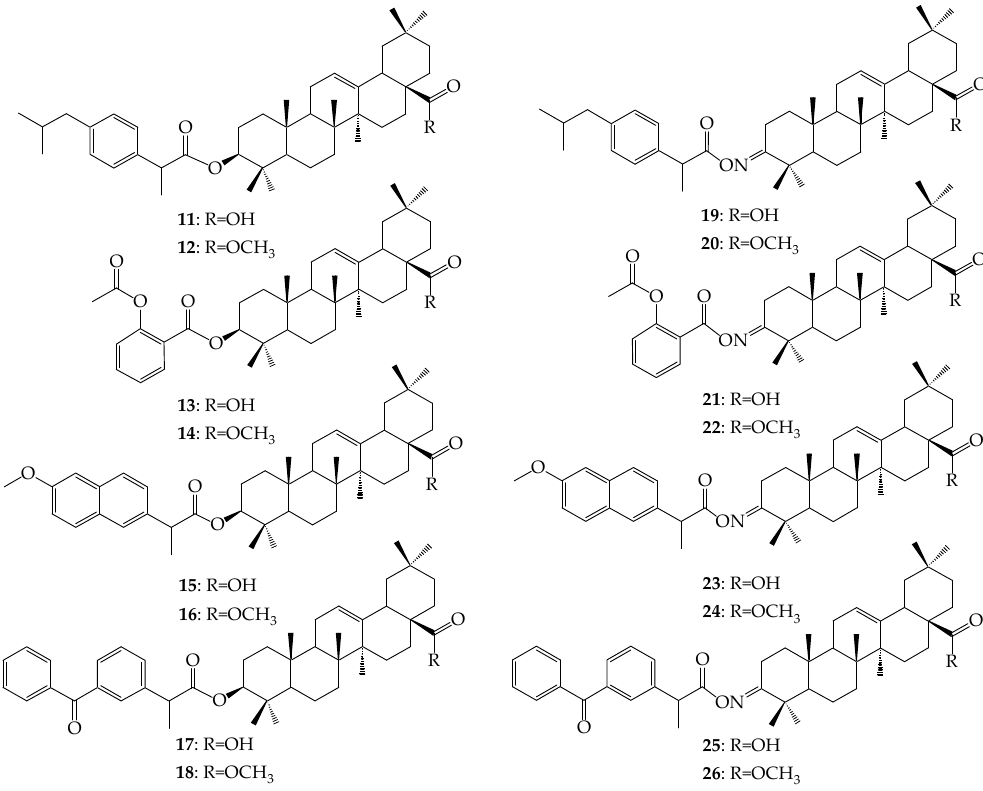
Figure 3. Formulas of the final hybrid derivatives obtained.